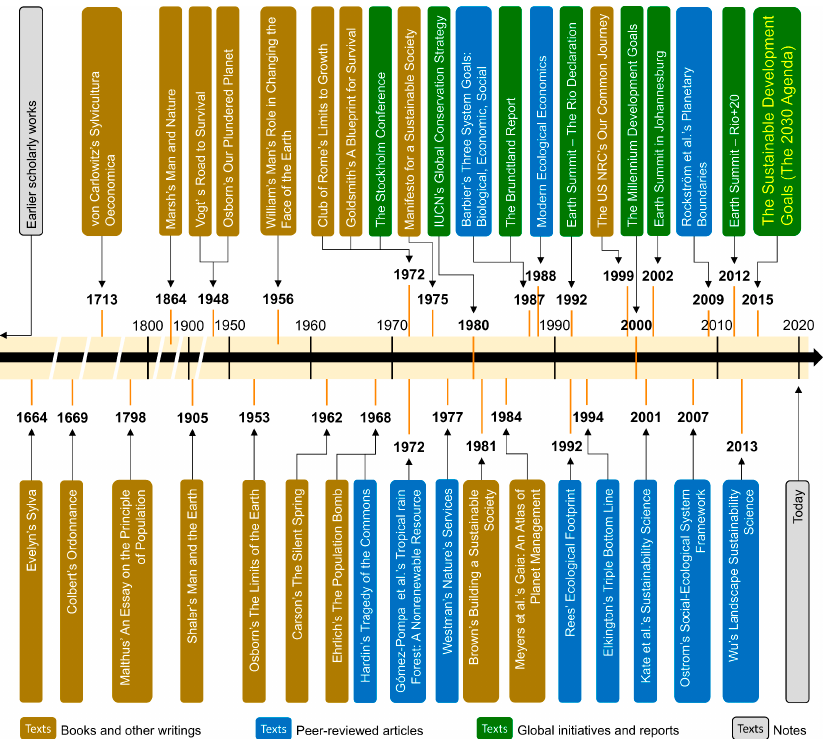
Figure 2. Timeline showing how the sustainability concept has been advanced by scholarly works and global policy initiatives.